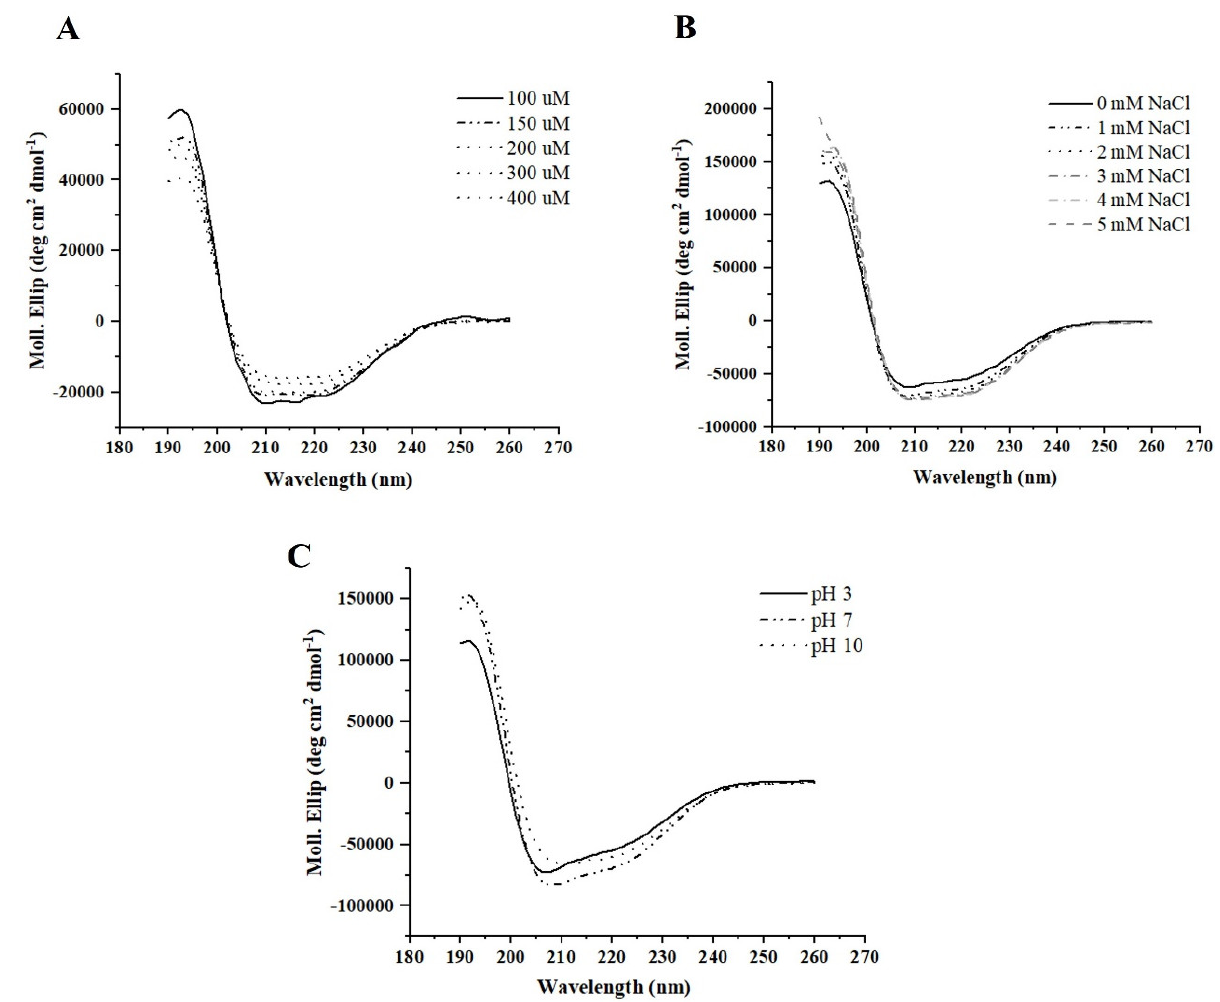
Figure 7. CD spectra of nanofibers NF-Doxo: effects of dilution ( A ), ionic strength ( B ), and pH ( C ). Graphs were created with OriginPro 2021.